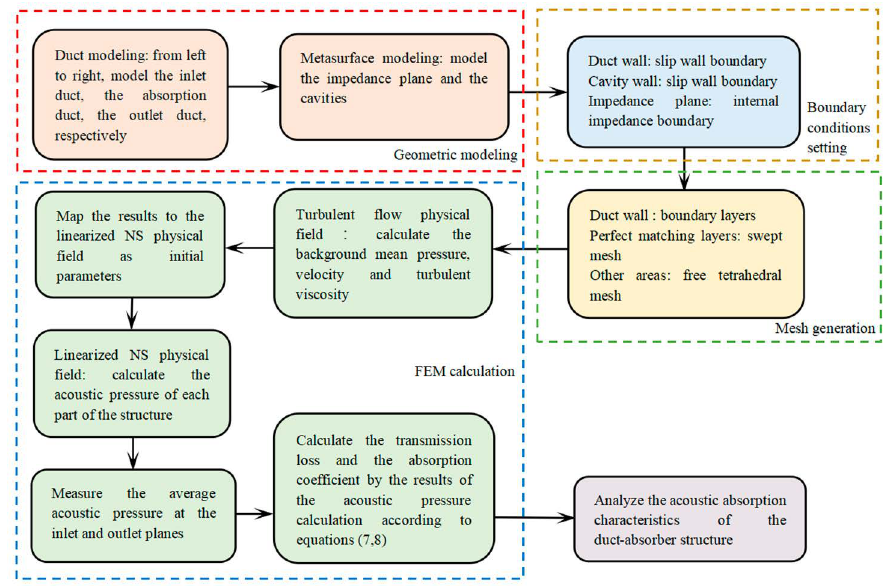
Figure 3. Computational flow chart of the impedance boundary Navier–Stokes equations method.